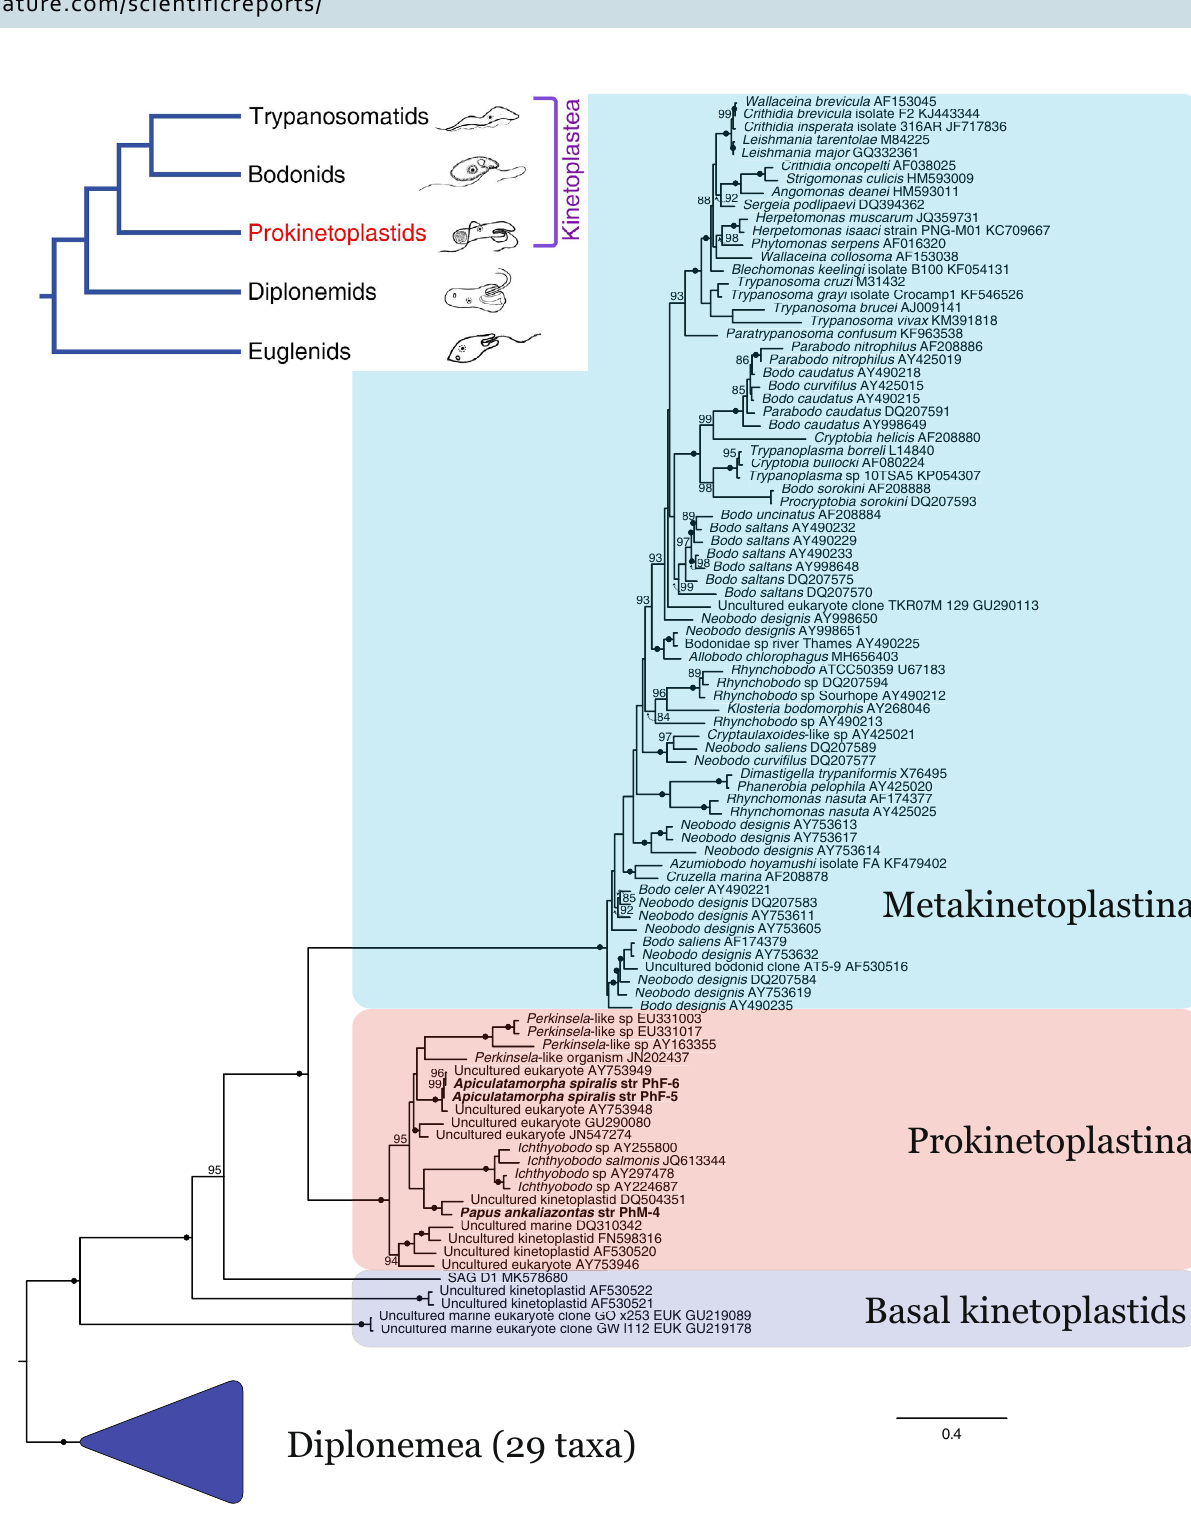
Figure 1. P. ankaliazontas and A. spiralis are prokinetoplastids. A maximum likelihood phylogeny of the 18S ribosomal RNA gene from diverse kinetoplastids and diplonemids (outgroup) was reconstructed with IQ-TREE v1.6.12 using the GTR + F + I + G4 model with 200 initial parsimony trees and 1000 ultrafast bootstrap replicates as a measure of support. P. ankaliazontas and A. spiralis affiliate with strong support with Prokinetoplastina, yet their precise relationships to parasitic and endosymbiotic prokinetoplastid groups could not be resolved. For clarity, ultrafast bootstrap values less than 85 are not shown. A phylogeny including more diverse euglenozoans as outgroup is presented in Supplementary Material, Fig.